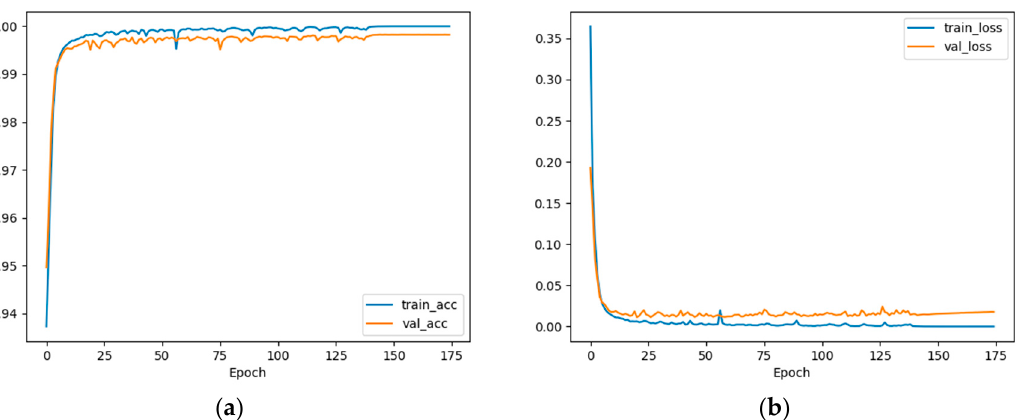
Figure 7. Accuracy and loss value curves of the IEEE118-bus test system. ( a ) Accuracy value curves of the IEEE118-bus test system. ( b ) Loss value curves of the IEEE118-bus test system.